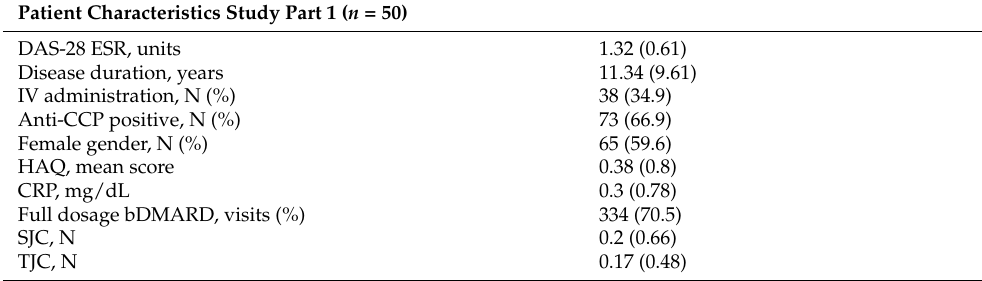
Table 1. Baseline patient characteristics for model quality assessment. Values are means (SD) if not stated otherwise. Only particular visits and 10 variables were considered for assessing model quality. SJC —swollen joint count; TJC —tender joint count; CRP —C-reactive protein; DAS–28 — disease activity score 28 joints; ESR —erythrocyte sedimentation rate; bDMARD —biologic disease- modifying anti-rheumatic drugs; anti-CCP —anti-cyclic citrullinated peptide; BMI —body mass index; HAQ —health assessment questionnaire.